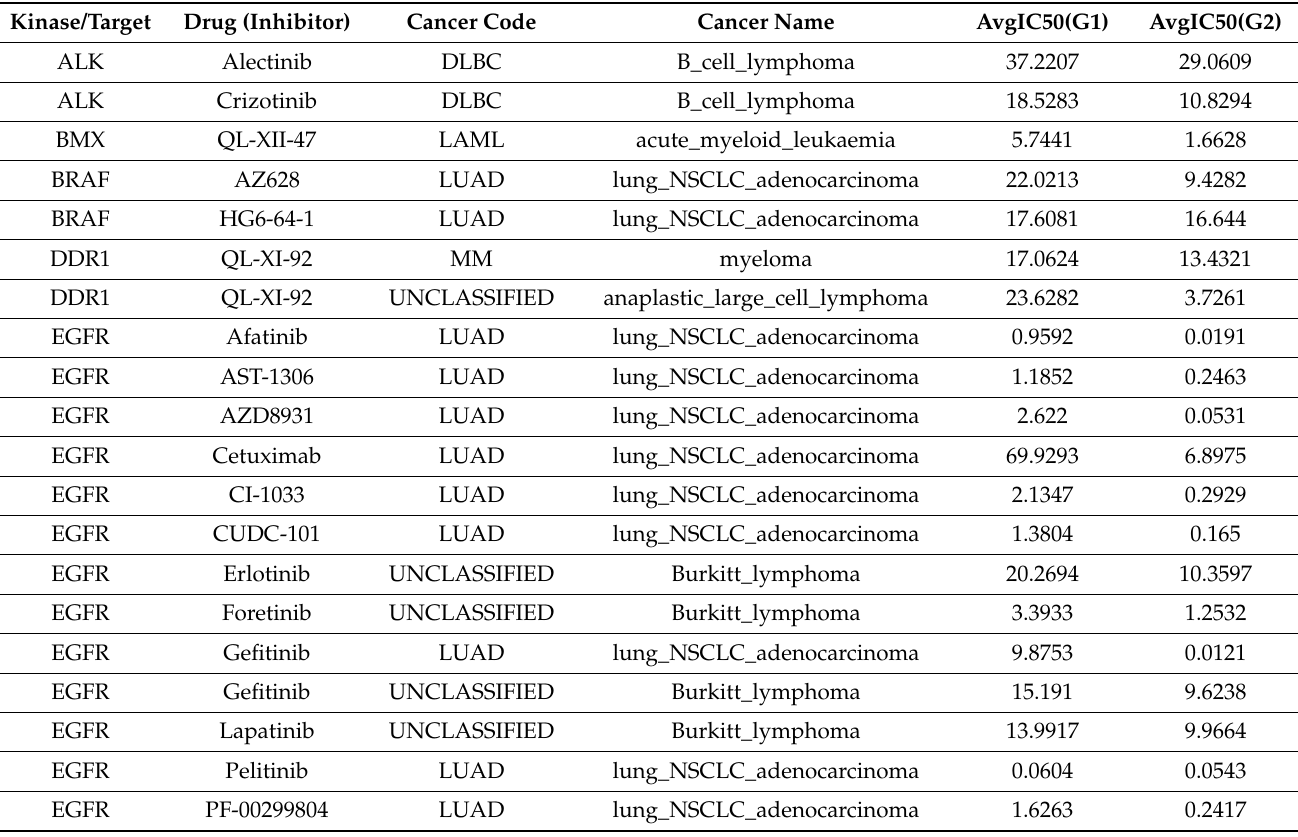
Table 3. Drug resistance results based on GDSC drug treatment data and the substructure mutations.